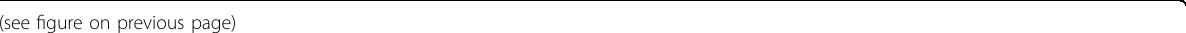
Fig. 6 Autophagy promoted survival in keratinocytes under oncogenic stress triggered by HRas G12V activity. A Immunoblots of ER:HRas G12V keratinocytes presenting autophagy markers (LC3II and p62) under 48 h of CQ (5 µM) treatment induced or not with 4OHT (50 nM). B The growth curve of induced ER:HRas G12V keratinocytes suggests loss of cell viability of keratinocytes that had their autophagy fl ux inhibited. The graph is representative of three independent experiments carried out in duplicate per condition and time point. C DNA content analysis by fl ow cytometry using PI of labeled ER:HRas G12V keratinocytes showed a drastic increase of sub-G1 population in 4OHT-induced keratinocytes treated with CQ. The graph is representative of two independent experiments. D Immunoblots of ER:HRas G12V autophagy-defective keratinocytes ( Δ ATG7 keratinocytes) and their control autophagy-competent scrabble (Scrb keratinocytes). The absence of ATG7 and LC3II in Δ ATG7 keratinocytes induced with 50 nM 4OHT con fi rmed successful knockout of the ATG7 gene and ablation of the autophagy pathway. E Growth curves using different 4OHT concentrations and consequently different levels of HRas G12V activity. The graph is representative of three independent experiments carried out in duplicate. F Flow cytometry of cell viability assay stained with annexin-V/PI. Density plot graphs (8th day) and their quanti fi cation indicate that autophagy activity is crucial for keratinocyte survival under oncogenic stress promoted by HRas G12V activity. The graph is representative of two independent experiments in which 30 × 10 3 cells were considered per condition and time point. Data presented as a mean (SD). Two-way ANOVA, * P ≤ 0.05, ** P ≤ 0.01, and *** P ≤ 0.001, Bonferroni post